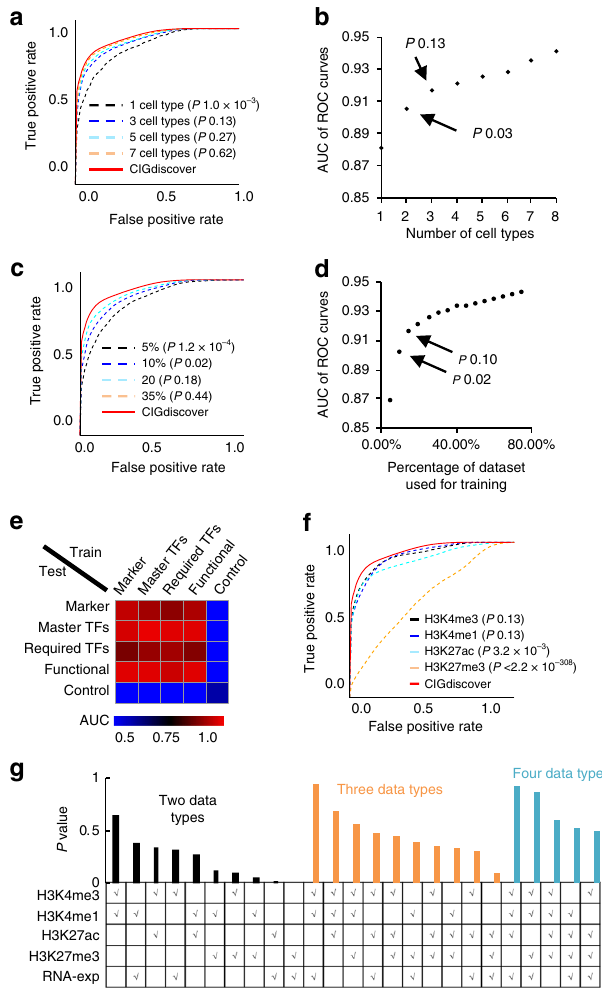
Fig. 2 CIGdiscover is robust and thus resilient to small or noisy training dataset. a ROC curves to show the performances of CIGdiscover and its variants trained based on data from different number of cell types. b Scatterplot to show the ROC AUC values for CIGdiscover variants trained by data from different number of cell types. c ROC curves to show performance of CIGdiscover and its variants trained with smaller number of known CIGs. d Scatterplot to show the AUC of ROC for CIGdiscover variants trained by smaller number of CIGs. e Heatmap to show AUC value of ROC for CIGdiscover variants trained by one category but tested by individual other categories of CIGs. f ROC curves to show performance of CIGdiscover and its variants that each only utilized all features of one type of histone modi fi cation. g Barplot to show P -values of difference in performance between CIGdiscover and its variants that each utilized a smaller combination of histone modi fi cations and RNA expression. P -values labeled in b and c indicate difference between ROC curves for CIGdiscover and the associated